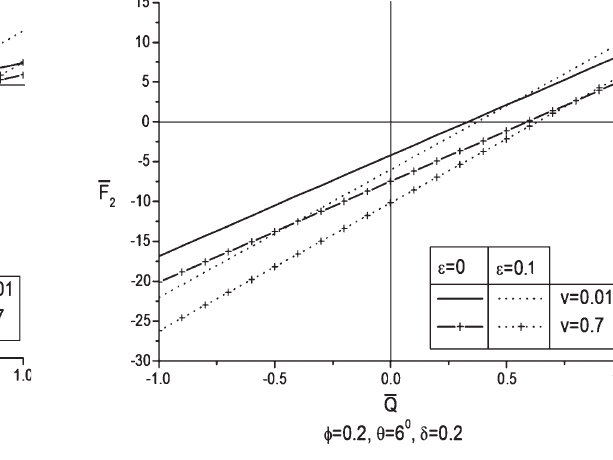
Fig. 10. Variation of the average outer Friction force versus Q for different values of v at different values of (cid:2) .